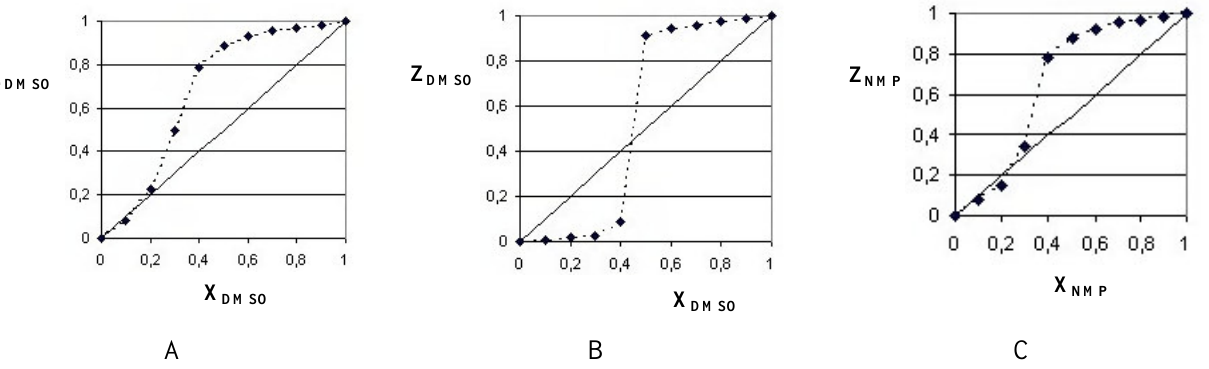
Figure 4 . Competition experiments of two different guests with respect to dehydrocholic acid host. (A): selectivity of dimethyl sulfoxide vs dimethylformamide; (B): selectivity of dimethyl sulfoxide vs N-methyl-2-pyrrolidinone; (C) selectivity of N-methyl-2-pyrrolidinone vs